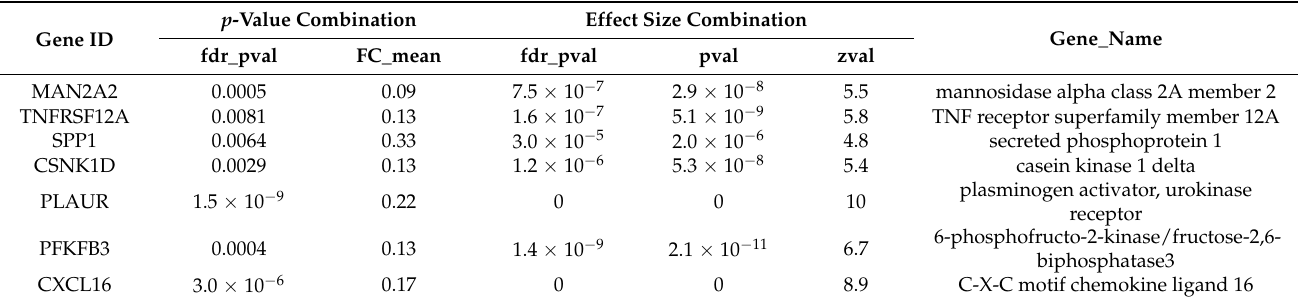
Table 1. Meta-analysis profile of six myocardial infarction (MI)